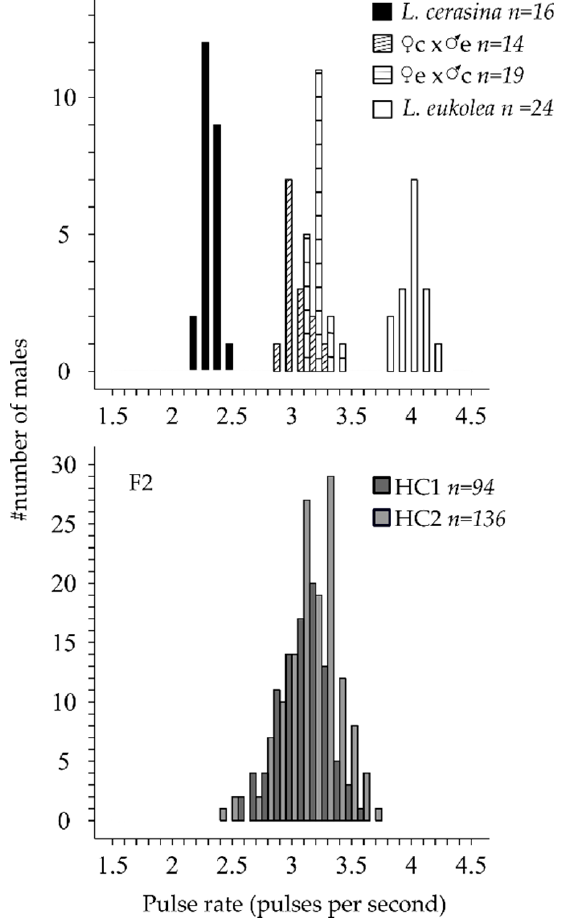
Figure 1. Phenotypic distributions for the parental lines and first- and second-generation hybrid offspring. The data from the F 1 hybrids in the top panel are from Oh et al., 2012 [43], and are shown to illustrate the F 1 distributions as well as the maternal bias in the pulse rate inheritance. The F 2 data are split by cross type (HC1 and HC2). Table 1. Phenotypic distributions. The mean and standard deviation of the pulse rate (pulses per second) and the sample size are shown for the parental species and the F 2 generation (both cross types, HC1 and HC2).